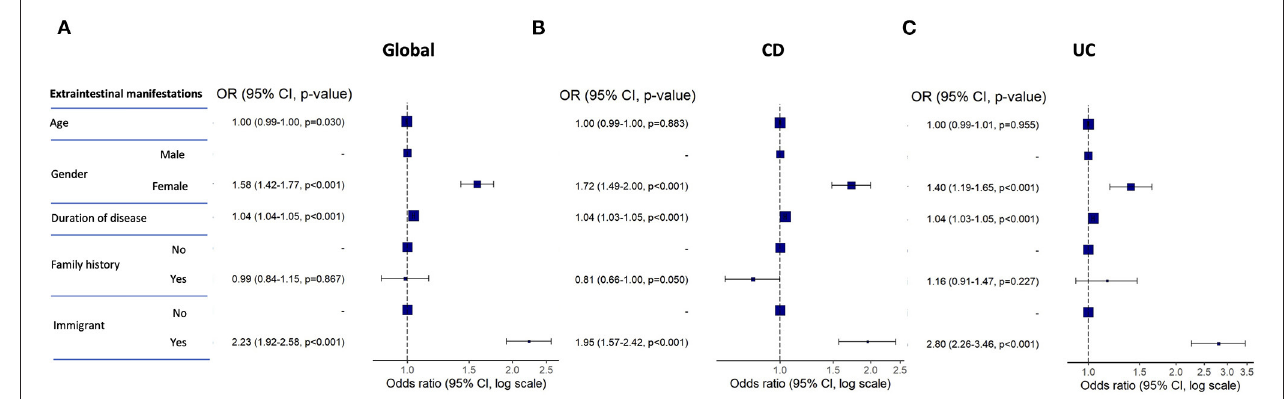
FIGURE 2 | Forest plots representing the odds ratio for presenting with EIMs in the multivariate analysis for the global (A) , CD (B) , and UC (C) cohorts of patients. CD, Crohn’s disease; UC, ulcerative colitis.